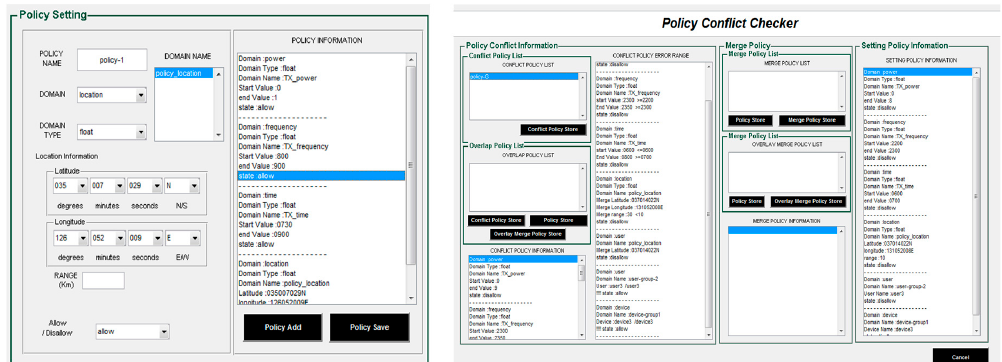
Figure 7. Policy engine implementation.